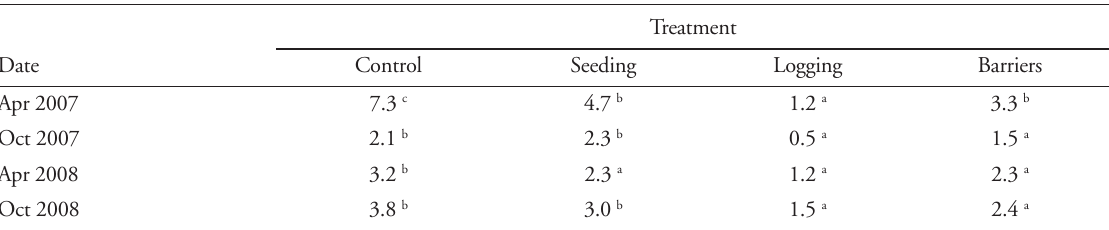
Table 2. Mean number of P. halepensis seedlings per square meter in each treatment. Means within the same date of observation, fol- lowed by the same letter are not significantly different at p ≤ 0.05 (n = 6). Treatment Control Seeding Logging